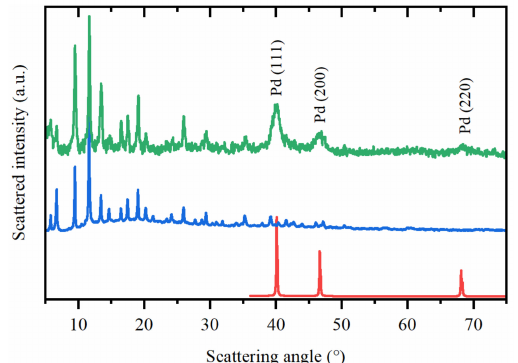
Figure 3. Ex situ XRPD patterns (Cu K α radiation) for metallic palladium (red), HKUST-1 (blue) and Pd@HKUST-1 sample